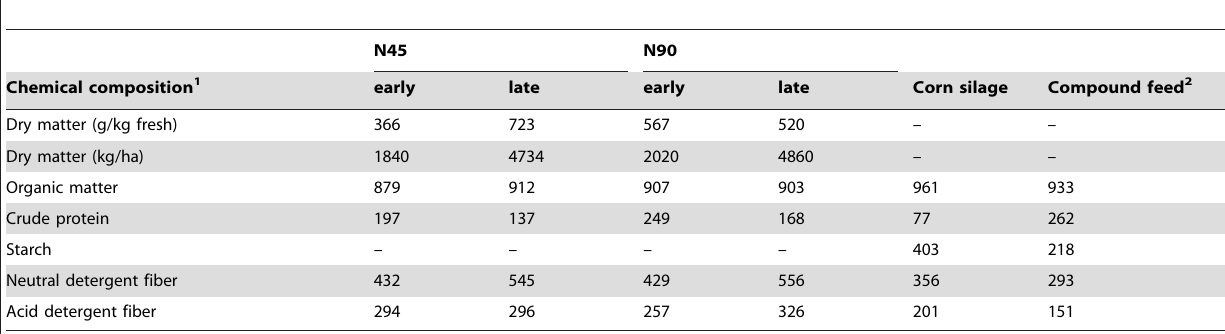
Table 1. Chemical composition of the diet consisting of grass silage of early or late maturity at two nitrogen (N) fertilization